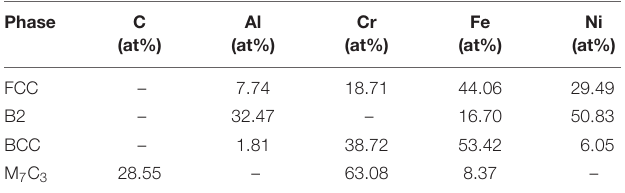
Frontiers in Materials |